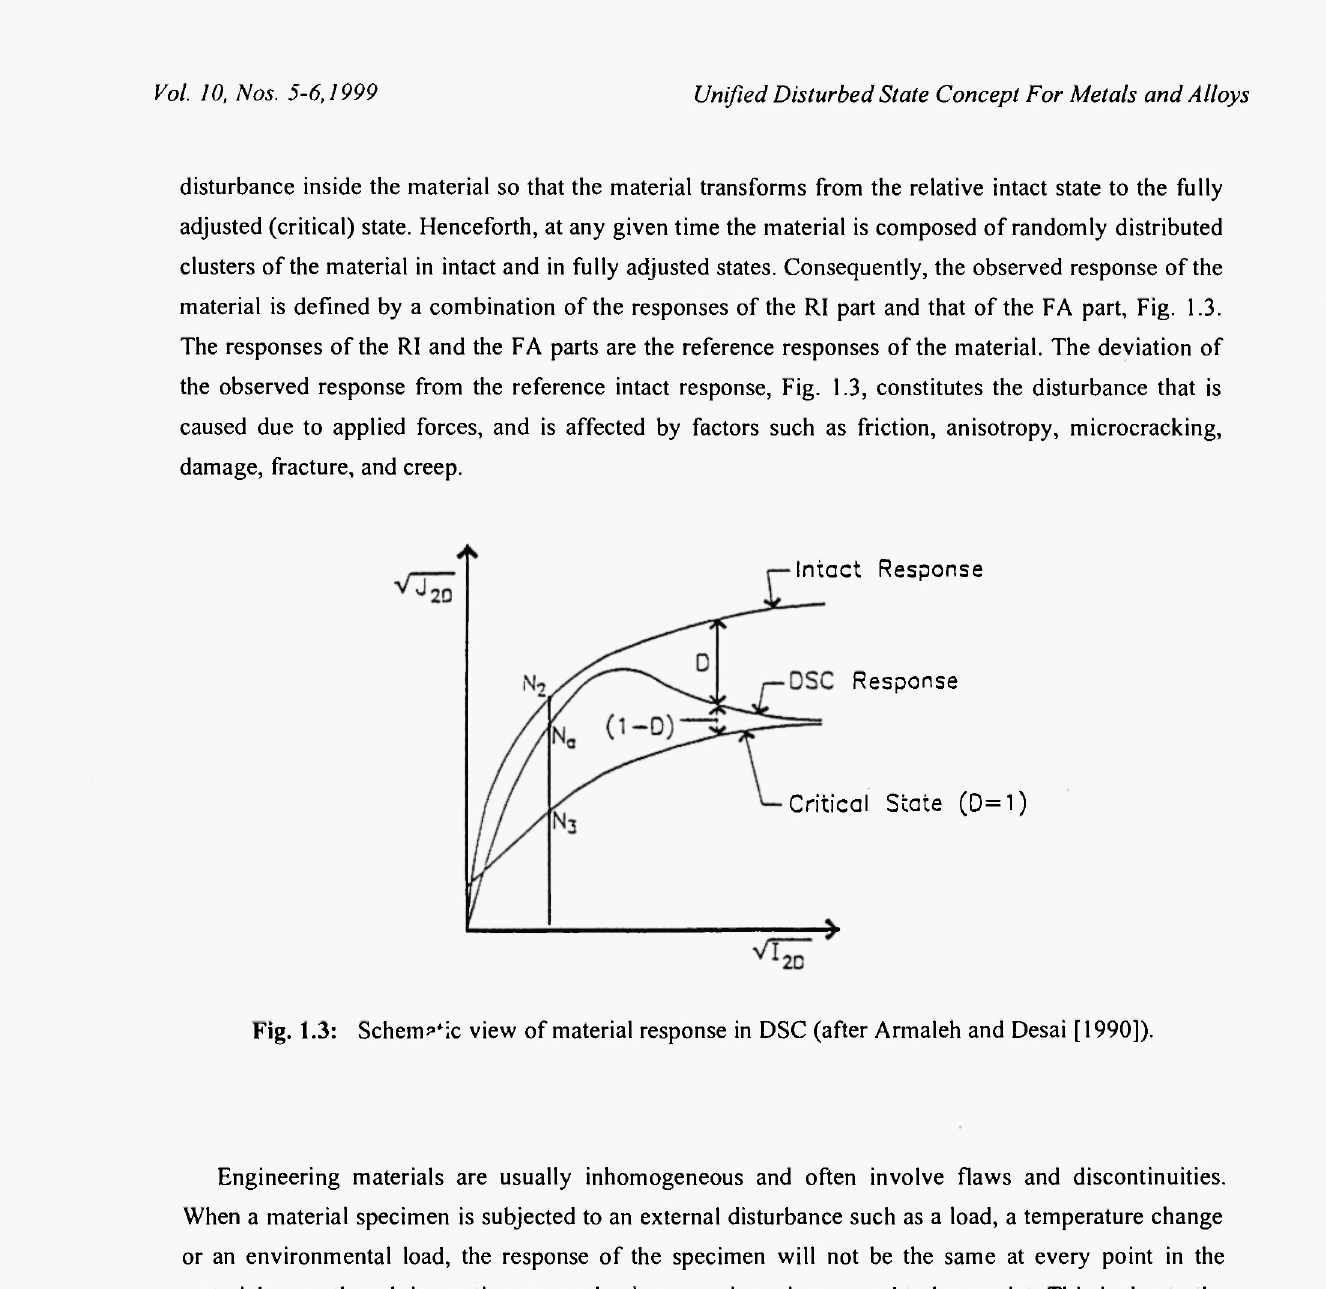
Fig. 1.3: Schem^ic view of material response in DSC (after Armaleh and Desai